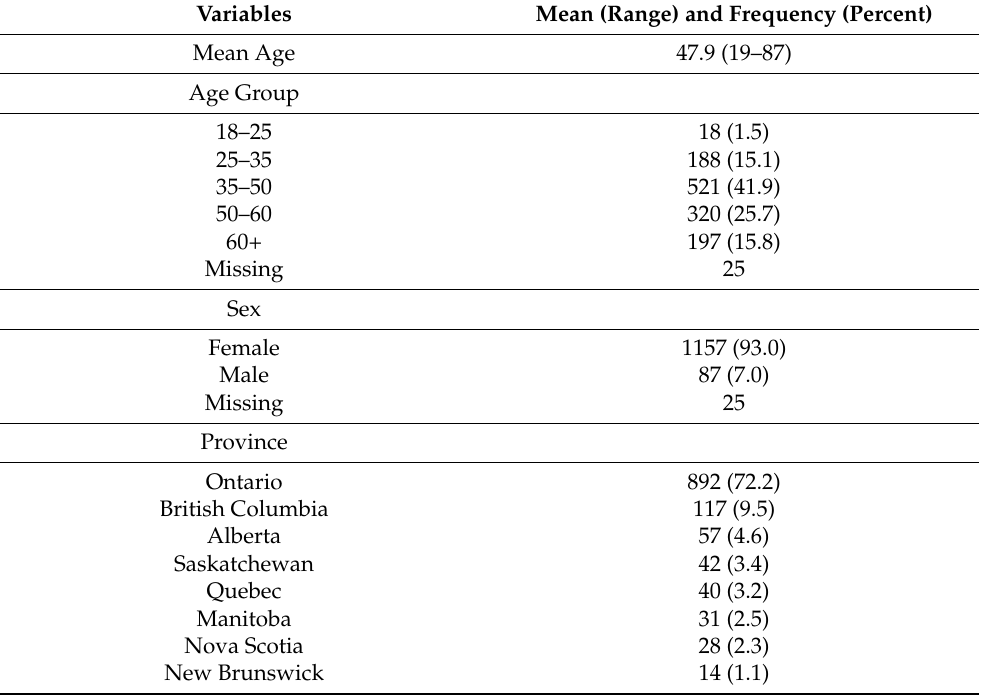
Table 1. Characteristics of the 1269 study